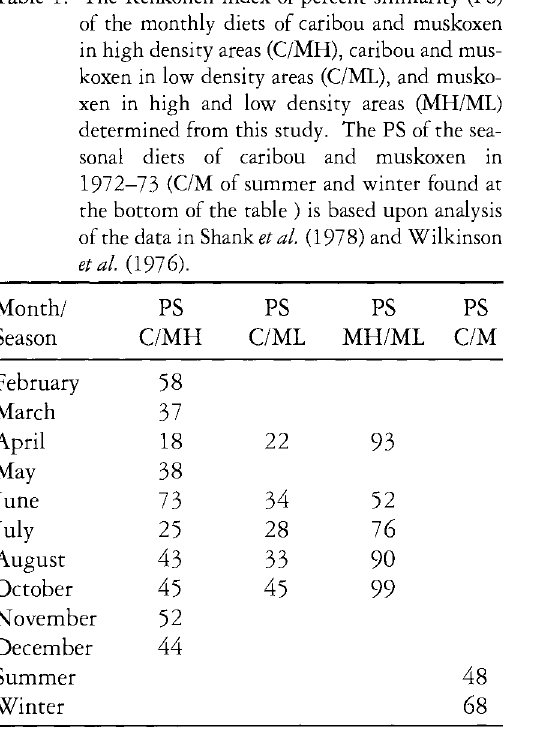
No other forages showed an area effect on standing crop. The standing crop of lichen was 2.96 g/m 2 (K =456). X 2 analysis of the occurrence data indicated significant differences (P<0.01) in occurrence of forages between the high and low density muskox ateas in the 3 upland habitats.